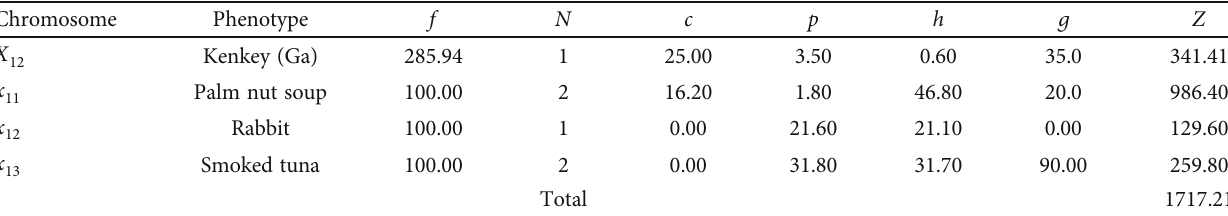
Table 4: Sample chromosome representation of child meal X